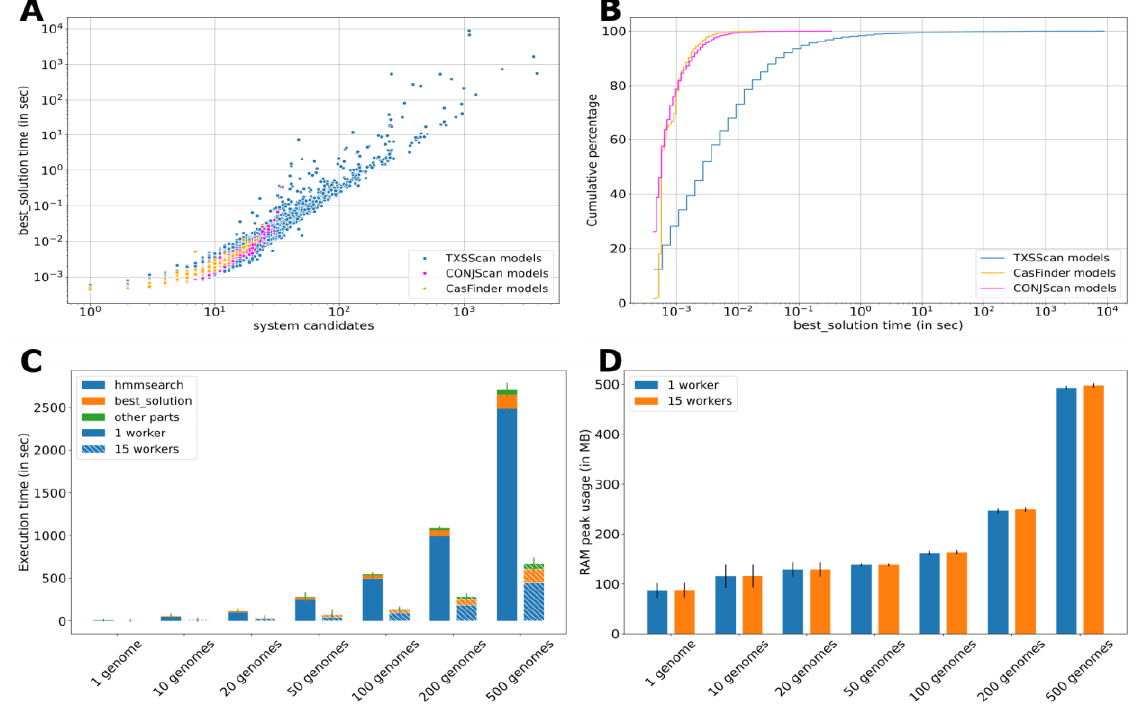
Figure 5 - Performance testing of MacSyFinder v2. A. The time spent by MacSyfinder in the resolution of the best solution grows exponentially with the number of solutions (Fig. S3 (Abby, 2023)) and with the number of candidate systems. B. Although the algorithm runs in exponential time, the broad majority of the runs complete the best solution resolution within 1 second. C. The mean time spent by MacSyFinder searching genes with hmmsearch (HMMER) is large compared to the other parts of the program, and grows with the number of genomes in the dataset (“gembase” mode). However this time can be significantly reduced when using multiple workers. D. The mean maximum resident memory used by MacSyFinder v2 is typically 100MB to analyse one genome and this grows with the size of the dataset to analyse, while being still manageable on a laptop, with less than 500 MB used for 500 genomes analysed. For the 1, 10, 20, 50, 100, 200 and 500 genomes datasets (panels C and D), respectively 1500, 150, 75, 30, 15, 7 and 3 non-redundant replicate datasets were sampled and analysed. Bars in C and D panels report the mean standard error